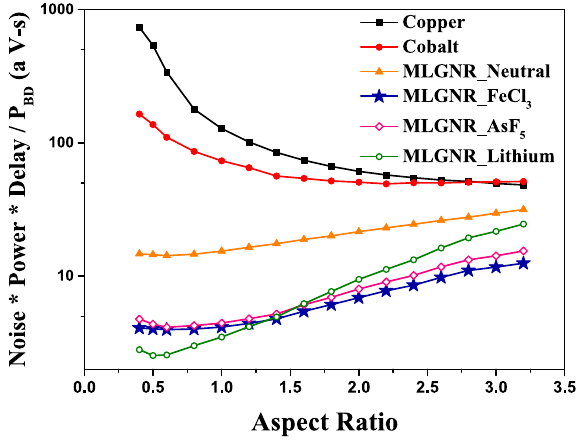
Figure 10. Optimized AR at minimum (noise power delay product / breakdown power) for 10 µ m long interconnects.